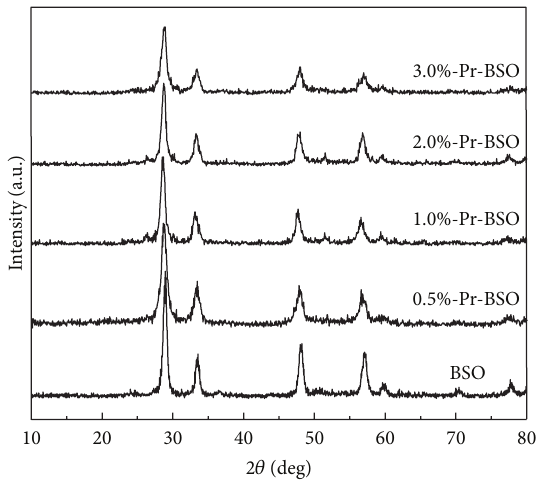
Figure 1: XRD analysis of different Pr-doped